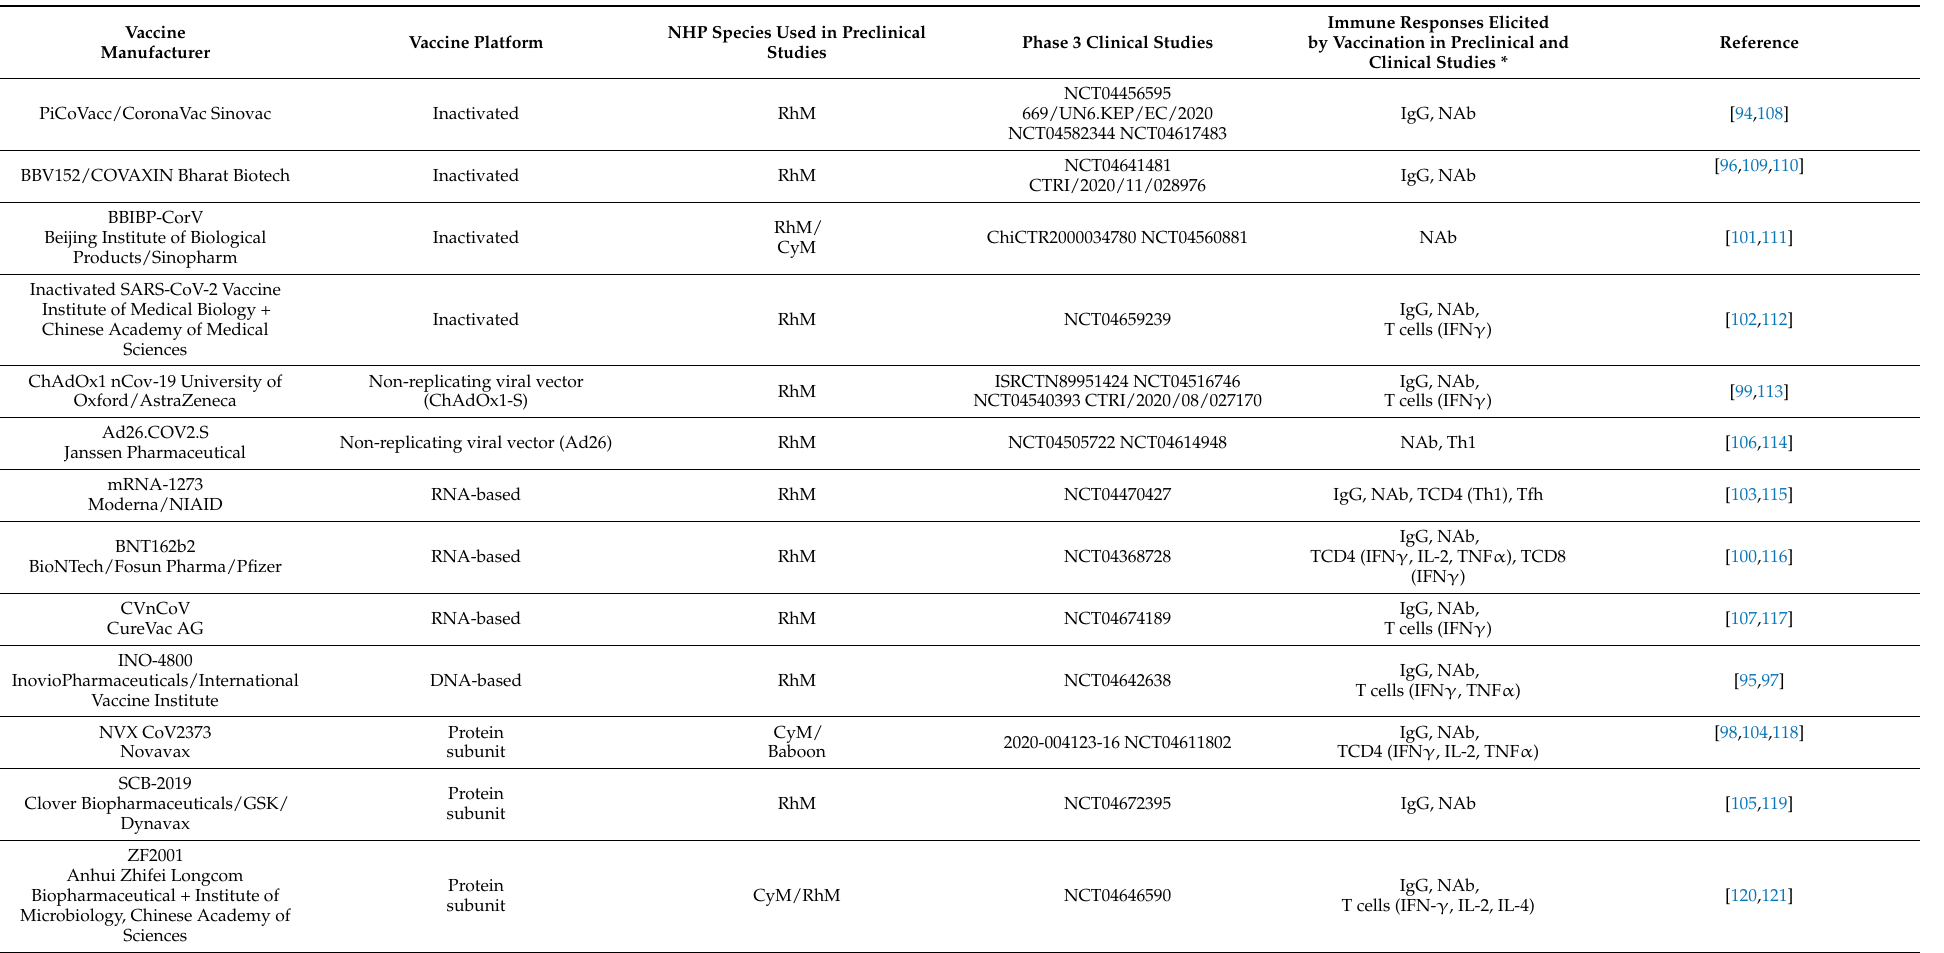
Table 4. NHP preclinical evaluation of SARS-CoV-2 vaccines that have reached phase 3 of clinical